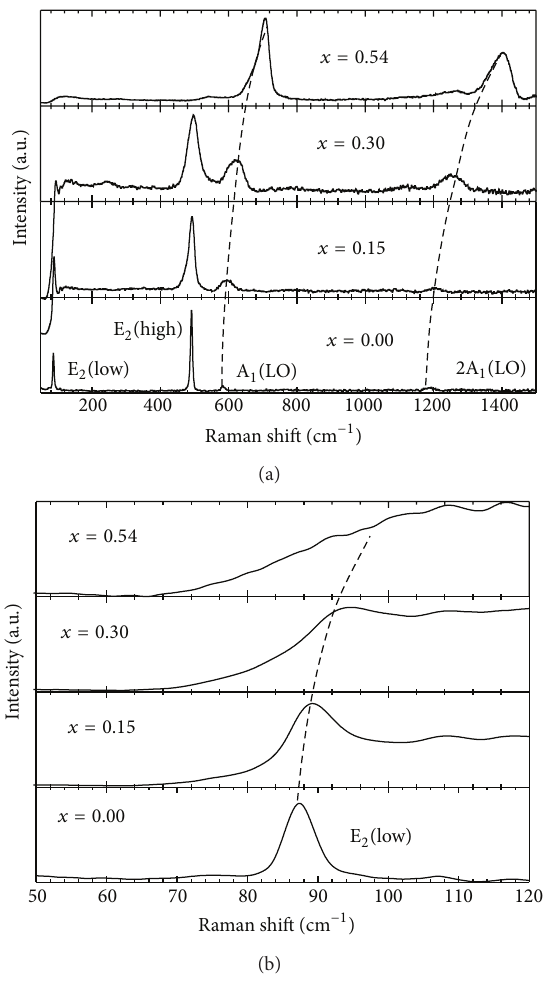
Figure 2: (a) Raman spectra of In 1−𝑥 Ga 𝑥 N ( 𝑥 = 0, 0.15, 0.30, and 0.54) thin films and (b) variation in the energy of E 2 (Low) using green laser excitation source (514.5 nm = 2.41 eV). The dashed lines are guides to eyes tracing variations of E 2 (low) and A 1 (LO) and its replica 2A 1 (LO) mode energies with increasing Ga atomic fraction.